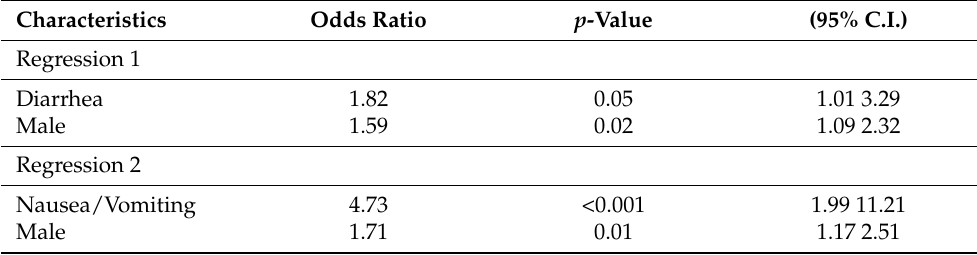
Table 6. Multivariate logistic regression for severity